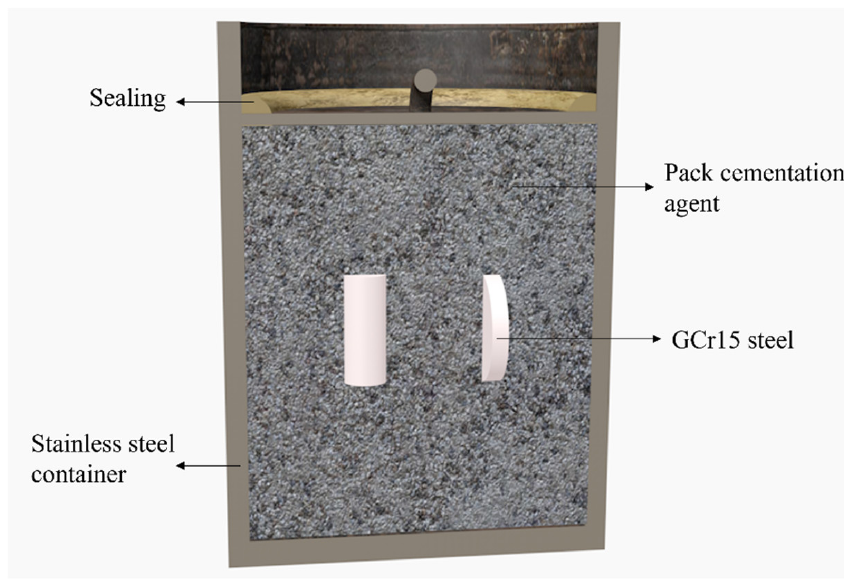
Figure 2. Vanadiumizing treatment schematic diagram.